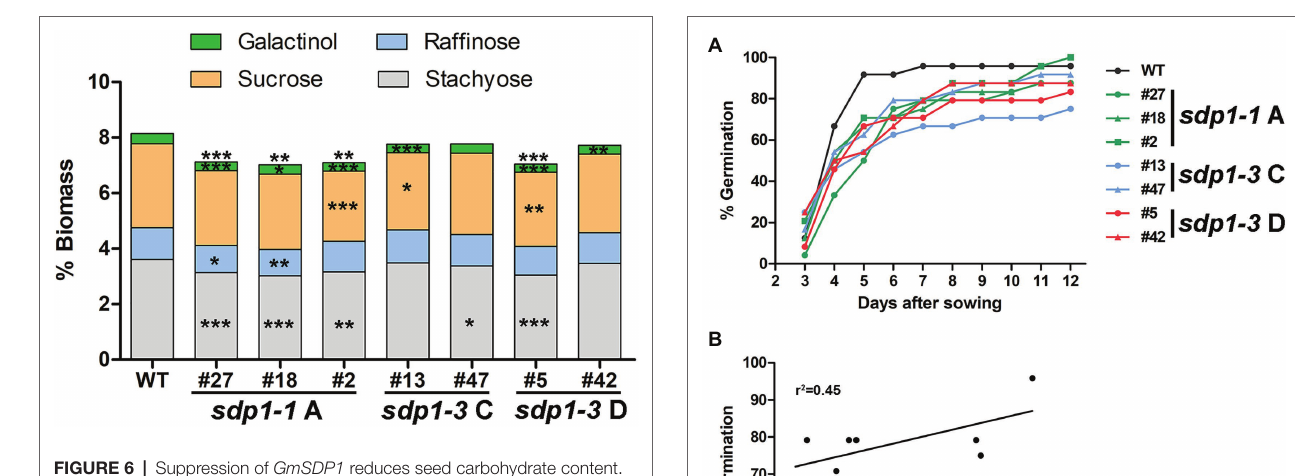
FIGURE 6 | Suppression of GmSDP1 reduces seed carbohydrate content. Mean carbohydrate content as a % of dry seed weight of T3 seed harvested from two plants each for select transgenic lines. Asterisks indicate significant differences compared to wild-type seed (*, p ≤ 0.05; **, p ≤ 0.01; ***, p ≤ 0.001; Student’s t -test).